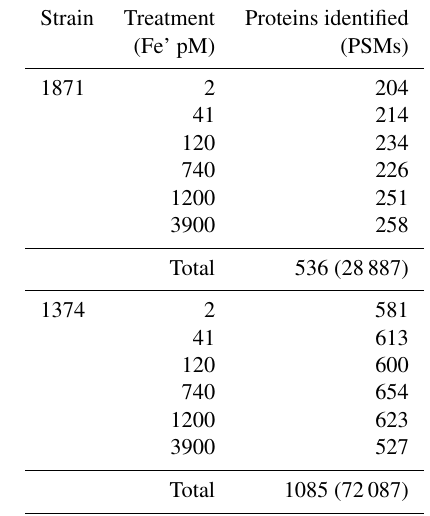
Table 1. Comparison of the total number of proteins and spectra measured in the proteome for each strain and/or treatment along with the number of differentially expressed transcripts between se- lect conditions for P. antarctica strain 1871 and strain 1374. Pro- teins were identified using a 1% FDR (false discovery rate) thresh- old, a peptide threshold of 95%, and a minimum of two unique pep- tides per protein. The total number of peptide-to-spectrum matches (PSMs) is given for the total of each strain in parentheses. A thresh- old of three spectral counts in at least one of the treatments was selected for inclusion in the comparative